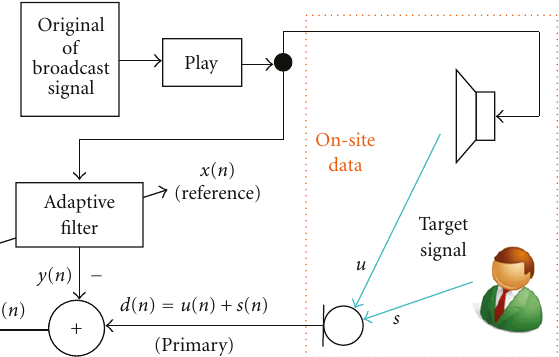
Figure 1: Conventional adaptive interference cancellation.